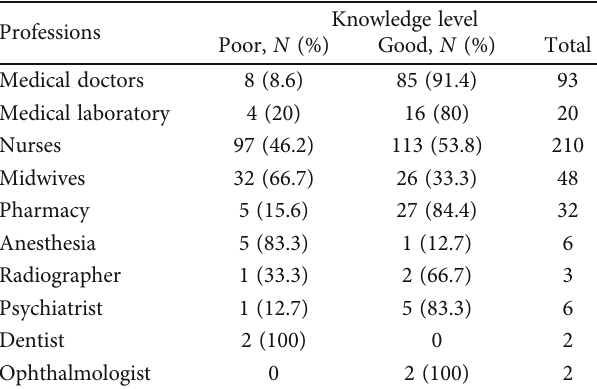
Table 3: Knowledge level of the health professionals about HBV early detection, transmission, and prevention at Tibebe Ghion Specialized Hospital from January 1 to February 30, 2021.